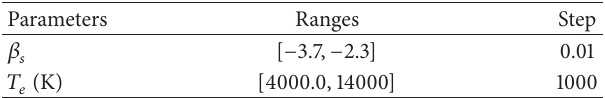
Table 4: Range of the parameters considered for the anomalous and free-free emission models. Parameters